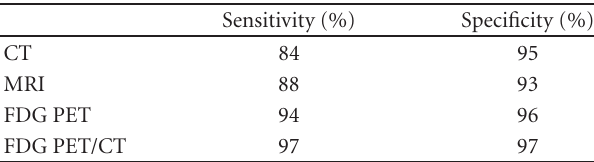
Table 2: Sensitivity and specificity of CT, MR, and FDG PET for detecting hepatic metastases from CRC [25].